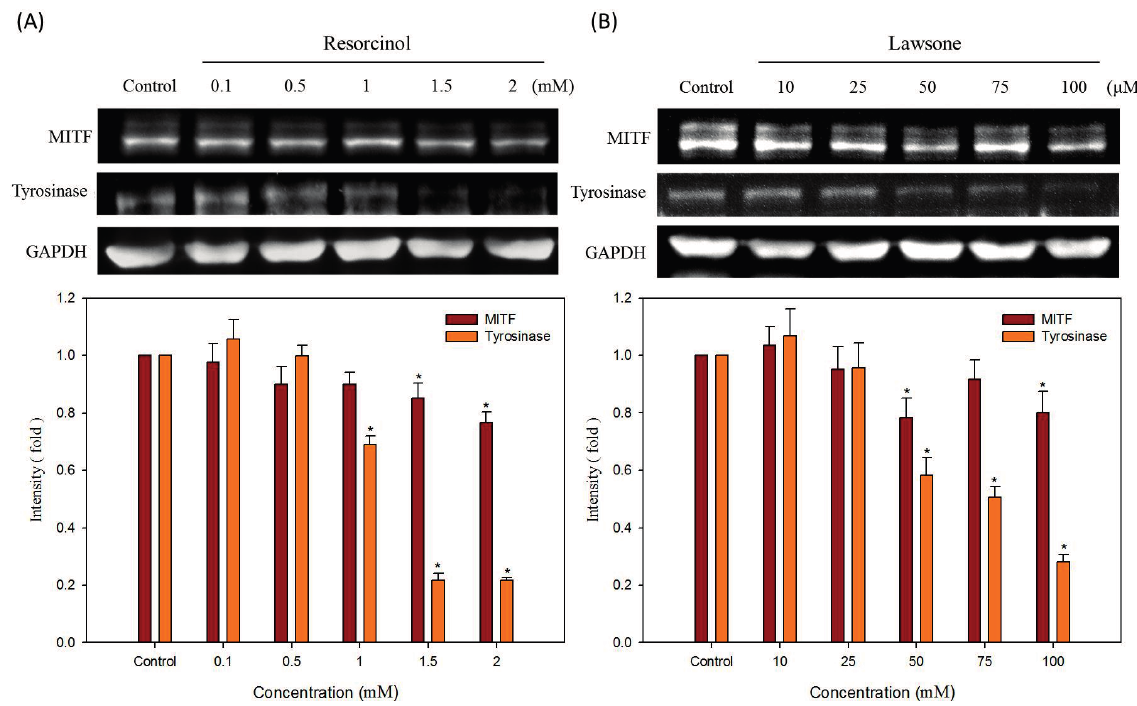
Figure 7. Effects of hair dyes ( A ) resorcinol and ( B ) lawsone on the protein levels of MITF and tyrosinase in B16-F10 cells. The protein level of GAPDH is used as an internal control. Each value is expressed as the mean ± S.E. ( n = 3). * p < 0.05 compared with the